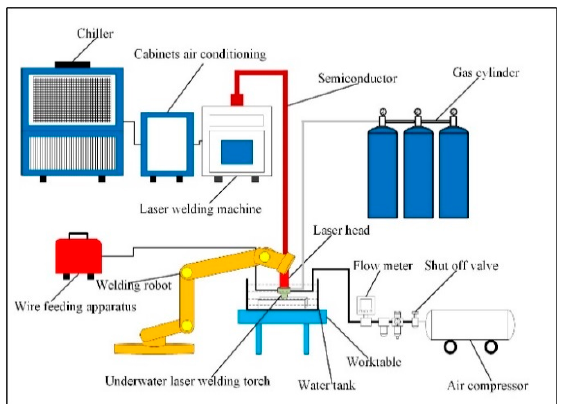
Figure 1. ULBW with filler wire experiment platform.